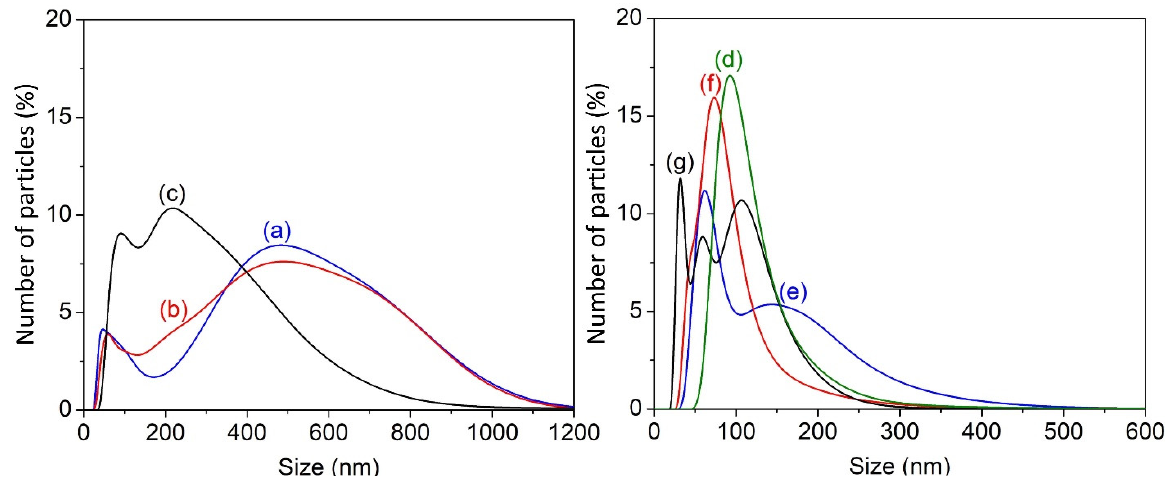
Figure 1. Particle size distribution plots of ( a ) NCS1, ( b ) NCS2, ( c ) NCS3, ( d ) NCS4, ( e ) NCS5, ( f ) NCS6 and ( g ) NCS7 chitosan nanoparticles. Table 2. Mean diameter and standard deviation of chitosan nanoparticles synthesized using differ- ent ultrasonication amplitudes and durations.